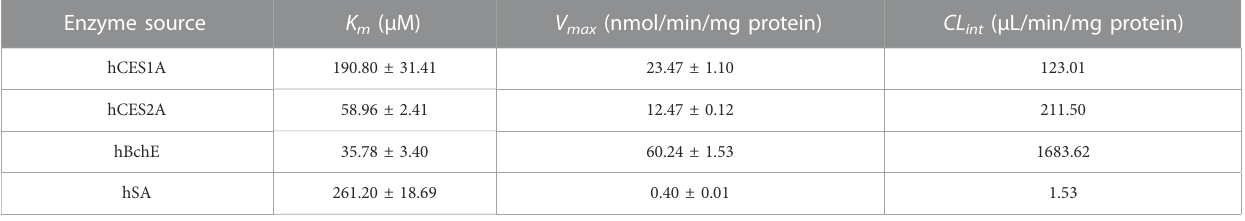
TABLE 2 Kinetic parameters of AB23A hydrolysis in hCES1A, hCES2A, hSA and hBchE. Enzyme source